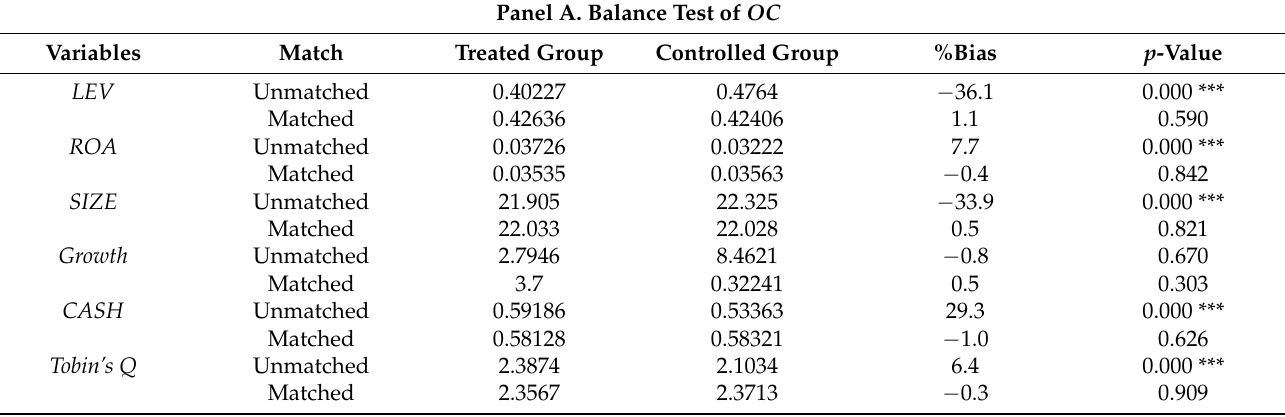
Table A3. Balance test of propensity score